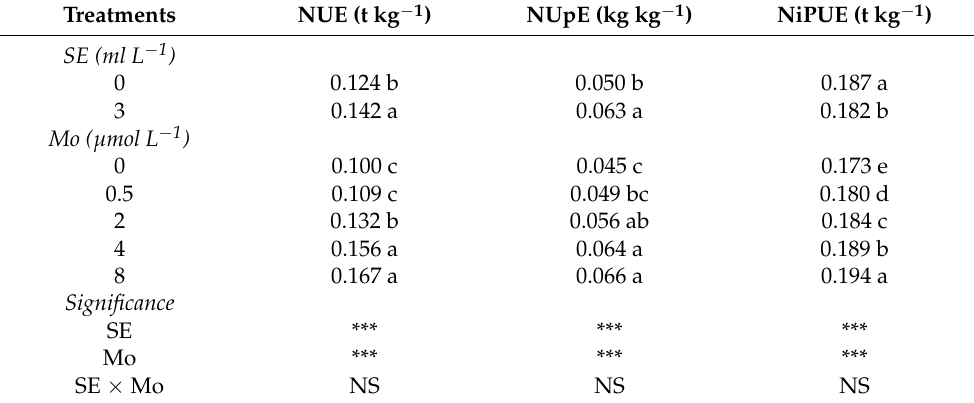
Table 4. Impact of SE application and Mo-biofortification on nitrogen use efficiency (NUE), nitrogen uptake efficiency (NUpE) and nitrogen physiological use efficiency (NiPUE) of spinach plants cultivated in a protected